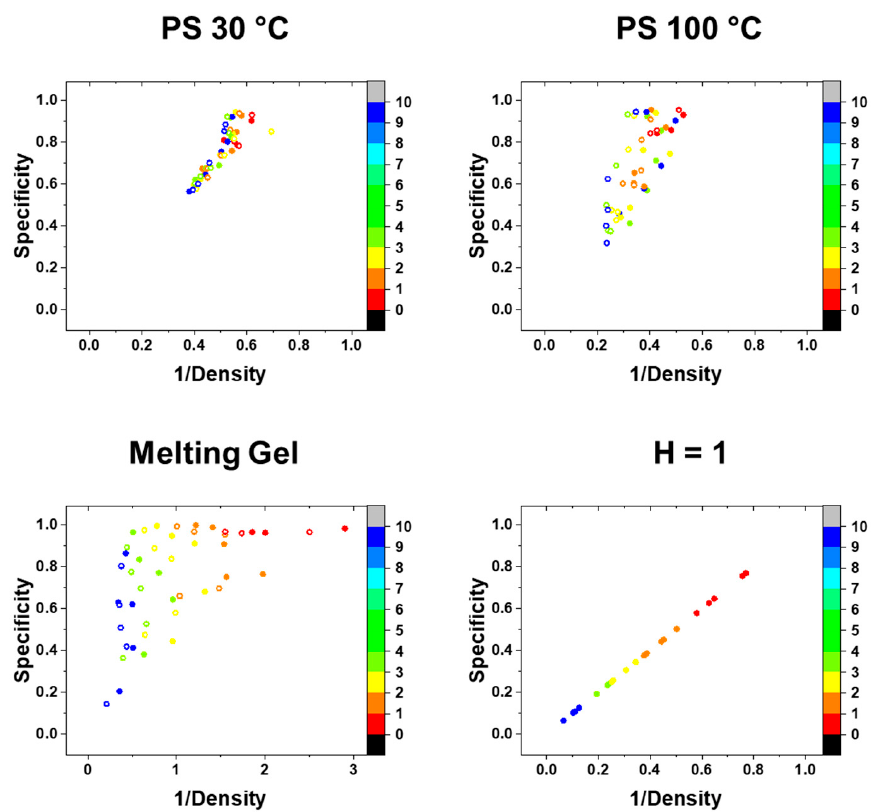
Figure 6. Specificity vs. 1/Density with color maps denoting gap ratio.